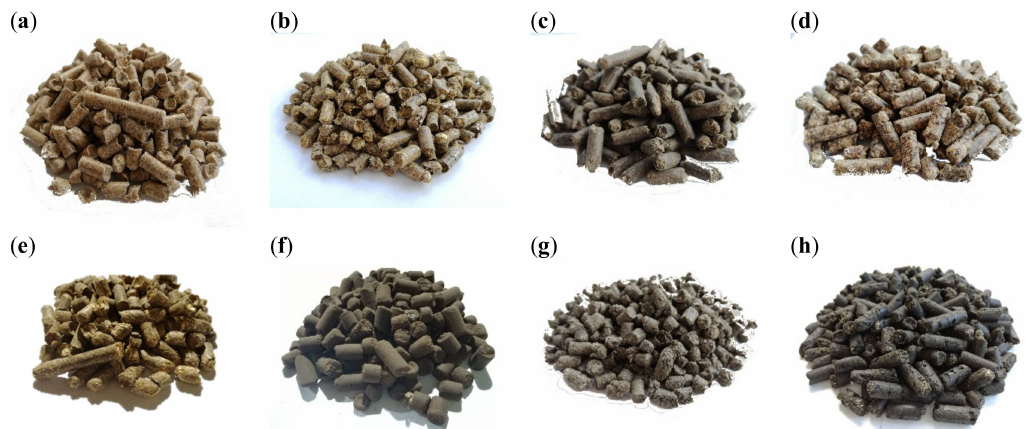
Figure1. Commercialpelletsinvestigatedinthestudy: ( a )chipsandsawdustpinewood, ( b )wheatstraw with the addition of rancid straw and hay, ( c ) digestate biomass, ( d ) corn settlements, ( e ) agricultural residues, ( f ) post-hydrolytic wood, ( g ) sunflower husk, ( h ) a blend of fine coal (45%) and straw